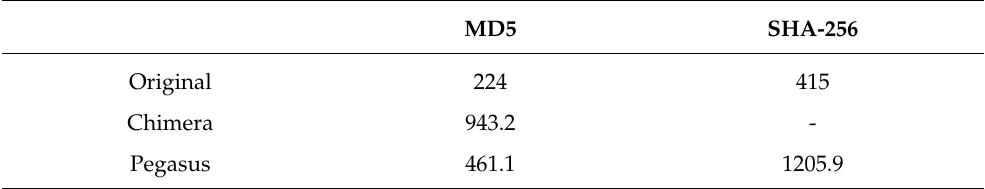
Table 6. Average number of qubits after embedding for different graphs at D-Wave for one round of hash functions. In the SHA-256 case, D-Wave did not find embedding on the Chimera